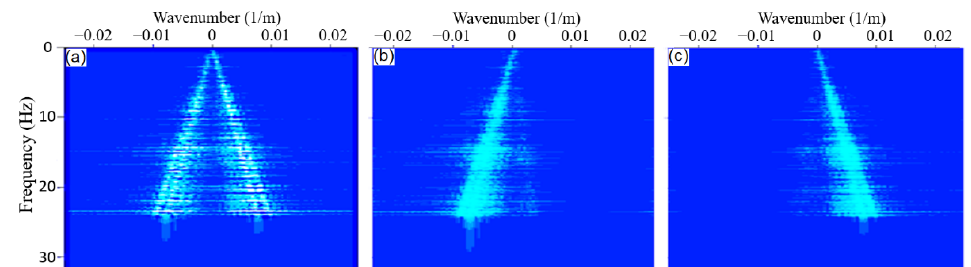
Figure 9. The retrieved VSP data from ANSI. The red line shows downgoing first arrival, the yellow arrows show downgoing multiples, and the blue arrows are pointing at upgoing waves or reflec- tions.